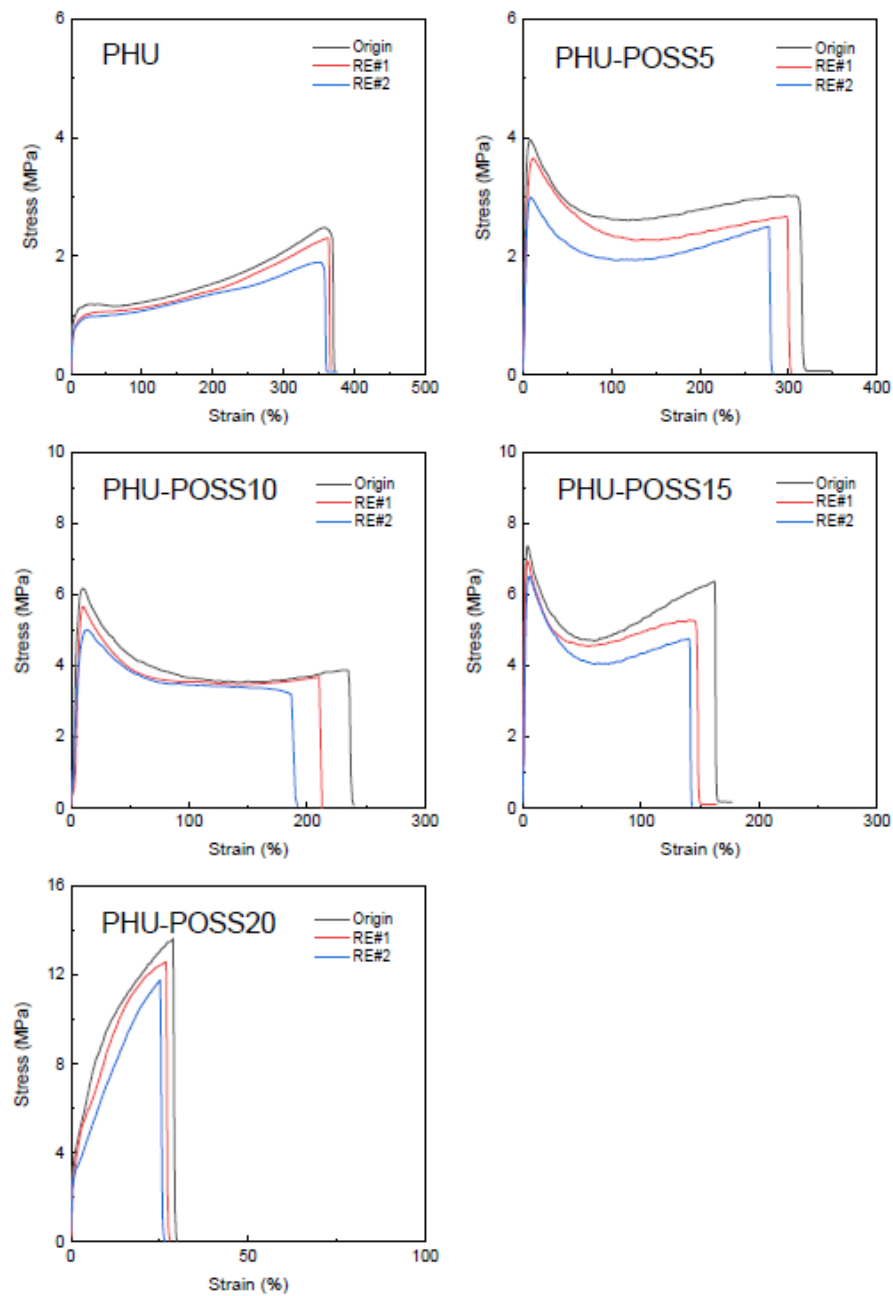
Figure 11. Stress-strain curves of PHU and PHU-POSS nanocomposites for reprocessing tests.